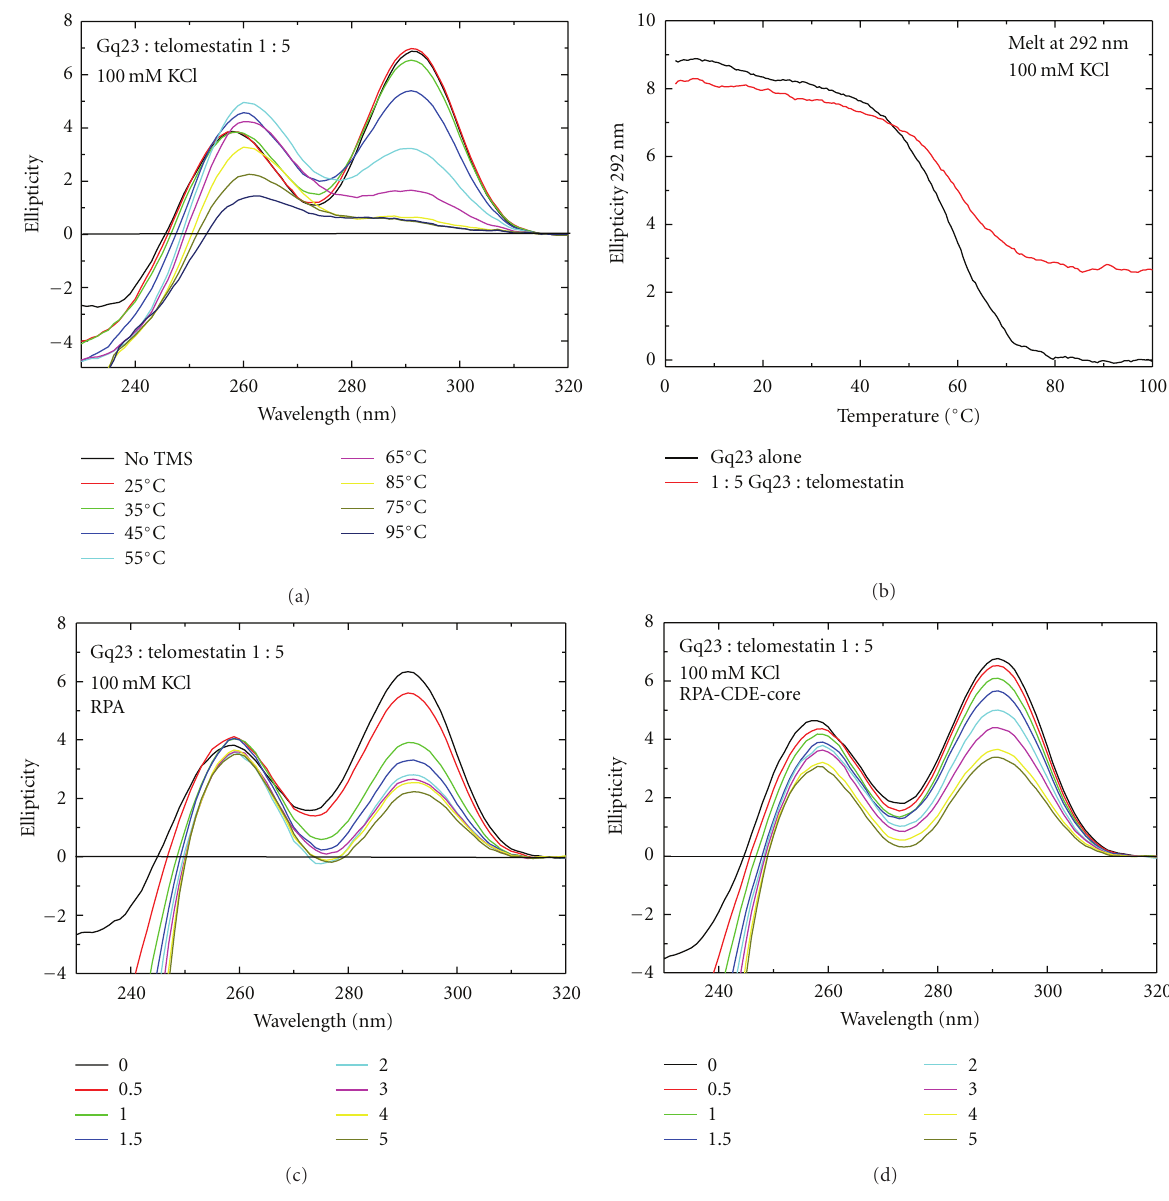
Figure 9: E ff ects of telomestatin and RPA on Gq23 with K + ions. (a) Gq23 : telomestatin 1: 5 at increasing molar ratios. (b) Melt at 292nm of Gq23 alone (black) and 1 :5 Gq23 :telomestatin (red) indicates no thermal stabilization of Gq23 upon addition of telomestatin. (c) Spectra of increasing molar ratios of RPA (0–5) added to above Gq23 :telomestatin complex and (d) spectra of increasing molar ratios of RPA-CDE-core added to the Gq23 : telomestatin complex. All spectra were recorded in